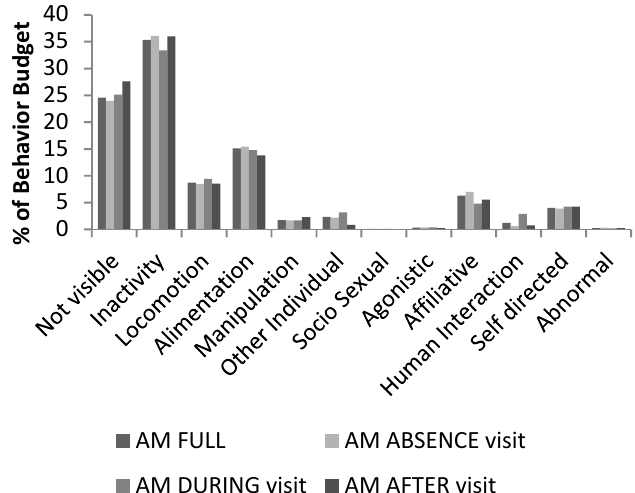
Figure 2. Chimpanzee behavior budget, based on the observation records (AM: from 10:00–15:00) used in this study. Behavior budget were calculated independently first using all available data (AM FULL), but also calculated for each Visitor condition (none, visit, after), to allow a visual quick overview.